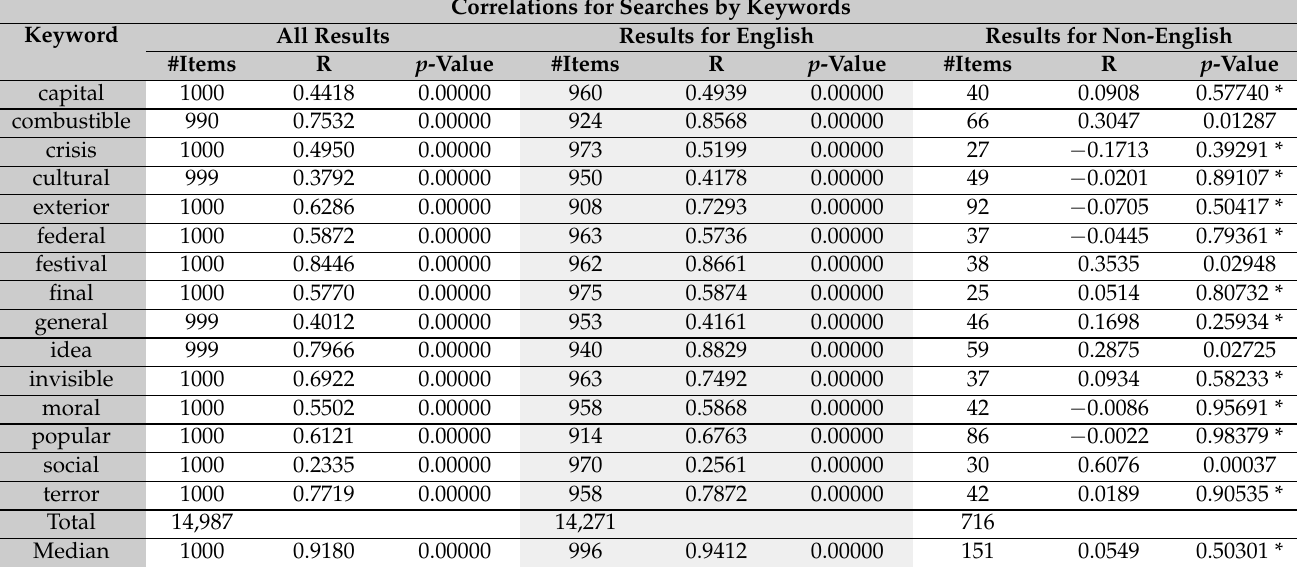
Table 8. Correlations between ranking by citations and the GS native ranking for searches by keyword.